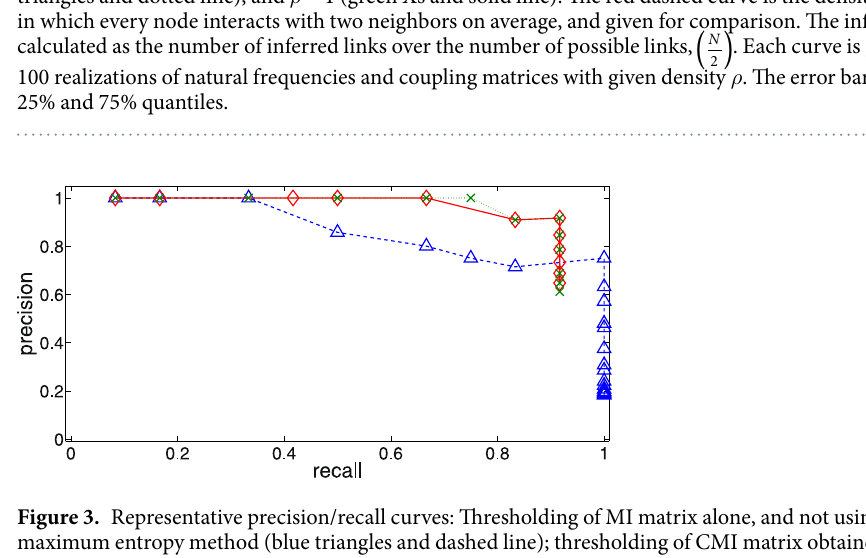
. Each curve is generated from 2